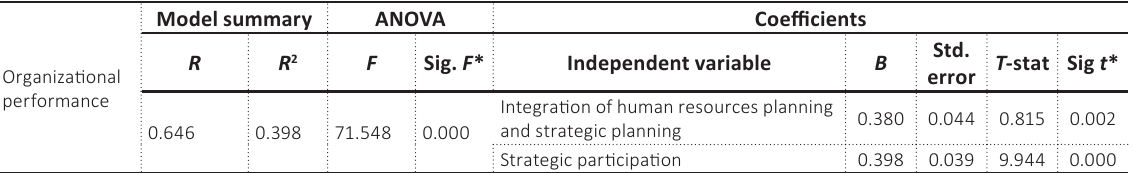
Table 3. Hypothesis test